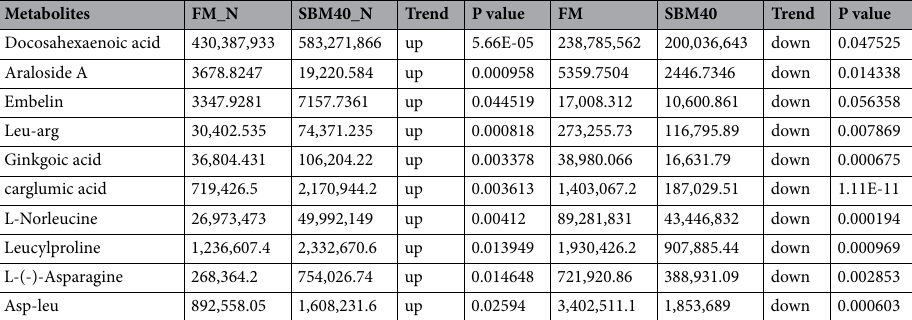
Table 9. 10 representative metabolites of the intensities increased significantly in DI contents and decreased significantly in DI tissues (n = 12). FM_N, fish meal control group DI contents; SBM40_N, 40% substitute level group DI contents; FM, fish meal control group DI tissue; SBM40, 40% substitute level group DI tissues.